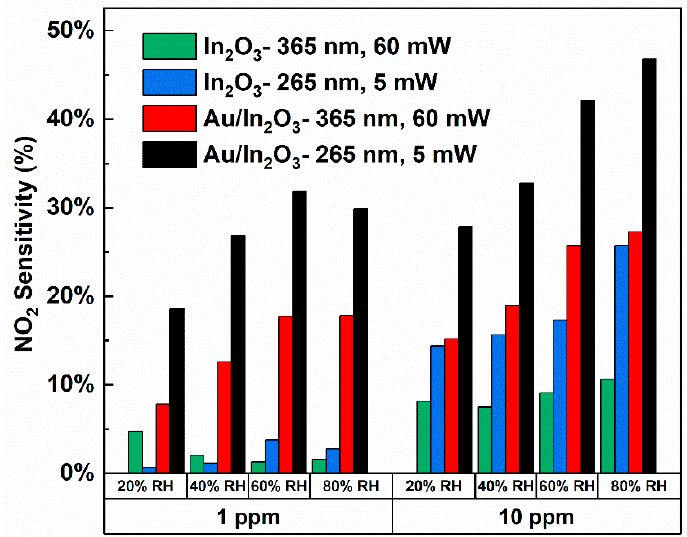
Figure 8. Sensitivities to 1 ppm and 10 ppm at various relative humidity.